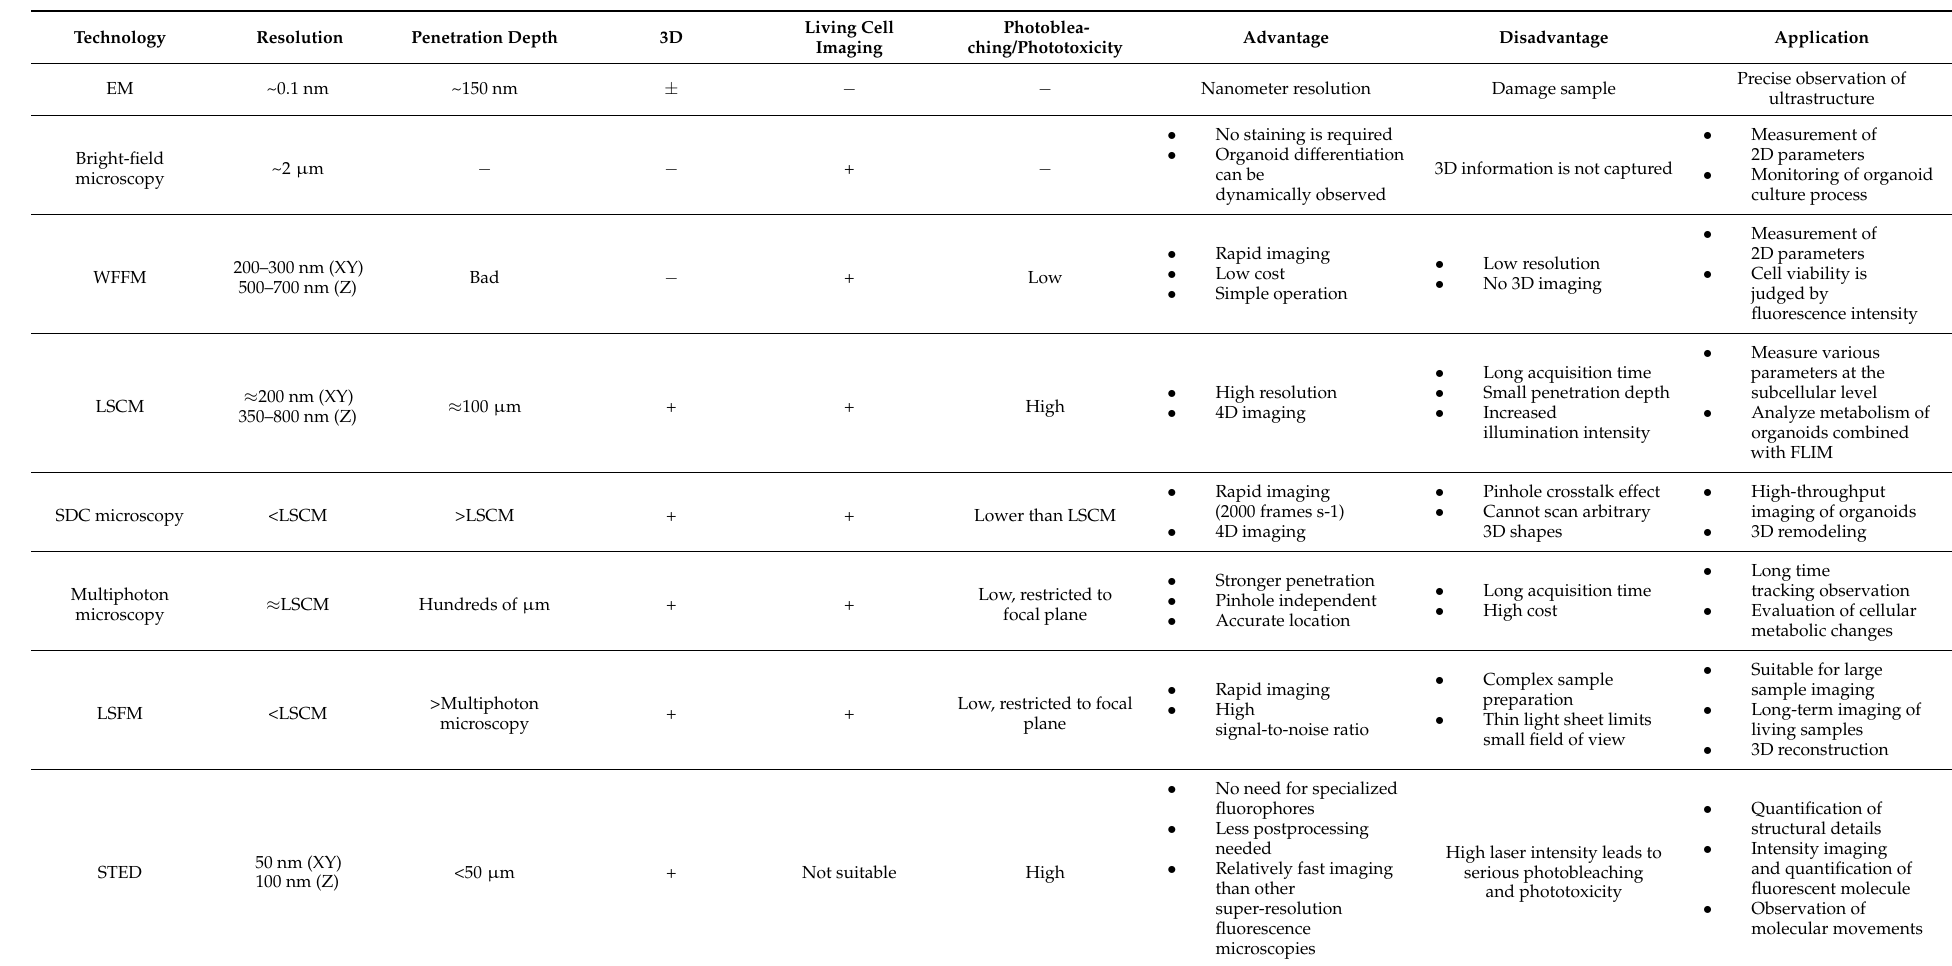
Table 1. The commonly used imaging technologies for